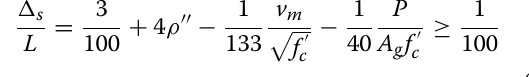
The value in the parentheses represent experimental reduction